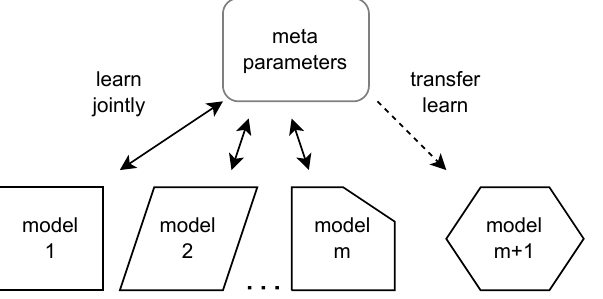
Figure 2. Hierarchical set-up transfer learning which can adapt to local circumstances (represented in the figure as odd